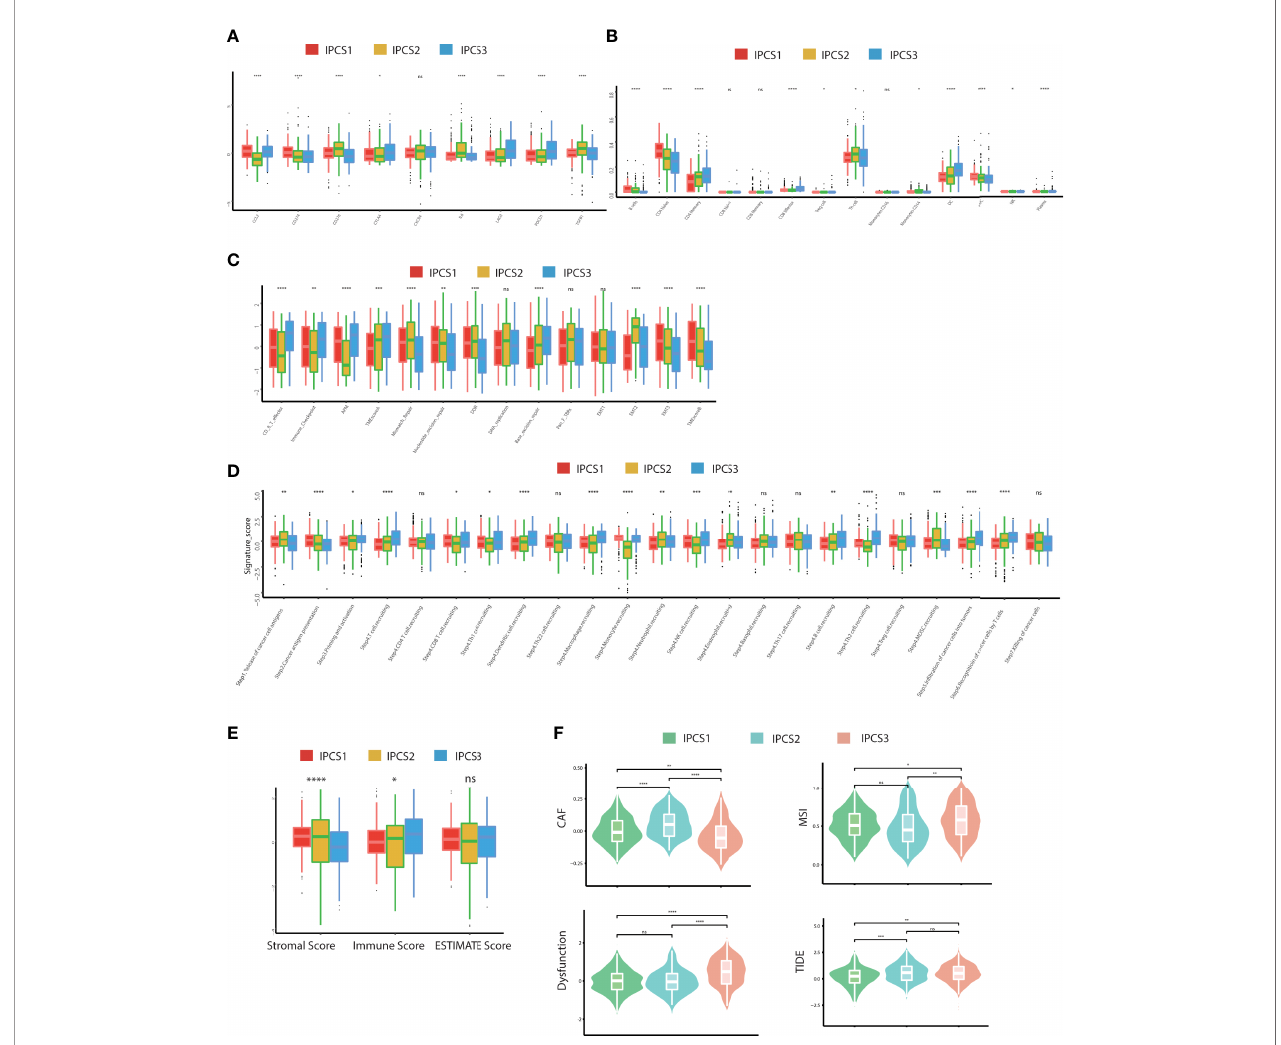
FIGURE 5 | Landscapes of speci fi c immune components and immune function scores. (A-D) The immune antigens, immune cells, immune pathways, and anti- cancer steps among the three subtypes. (E) ESTIMATE scores of two subtypes. (F) The immune function scores among the three subtypes. ns>0.05, p < 0.05, **p < 0.01, ***p < 0.001, ****p < 0.0001. ns, no signi fi